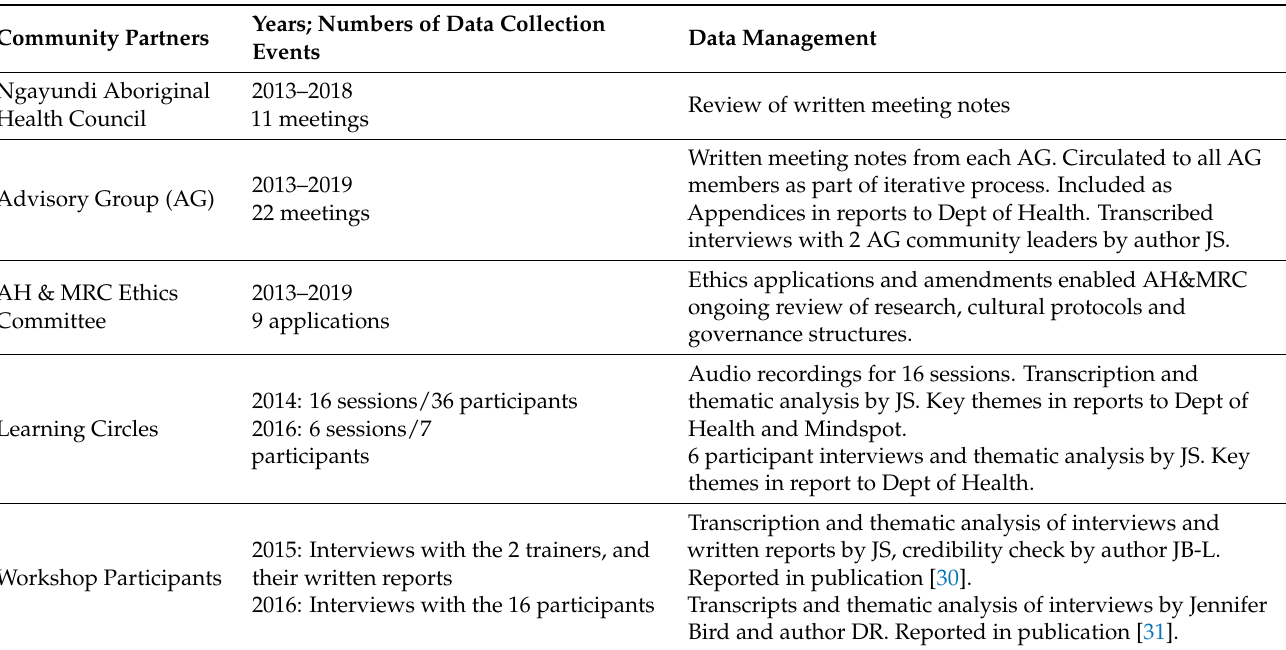
Table 1. Outline of